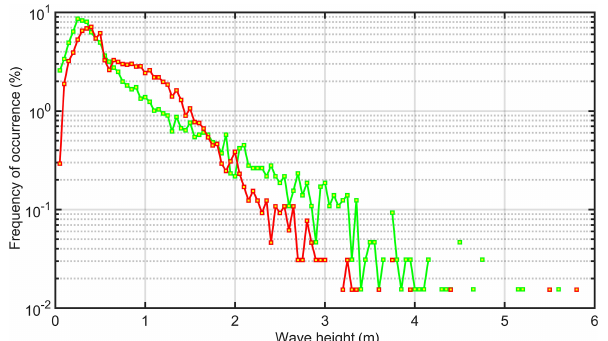
Figure 3. Empirical probability distributions of measured wave heights at Tallinnamadal (green) and modelled wave heights in the closest grid cell (red) with a resolution of 1cm in 2012–2016. The missing lines between the data points indicate gaps in the sets of